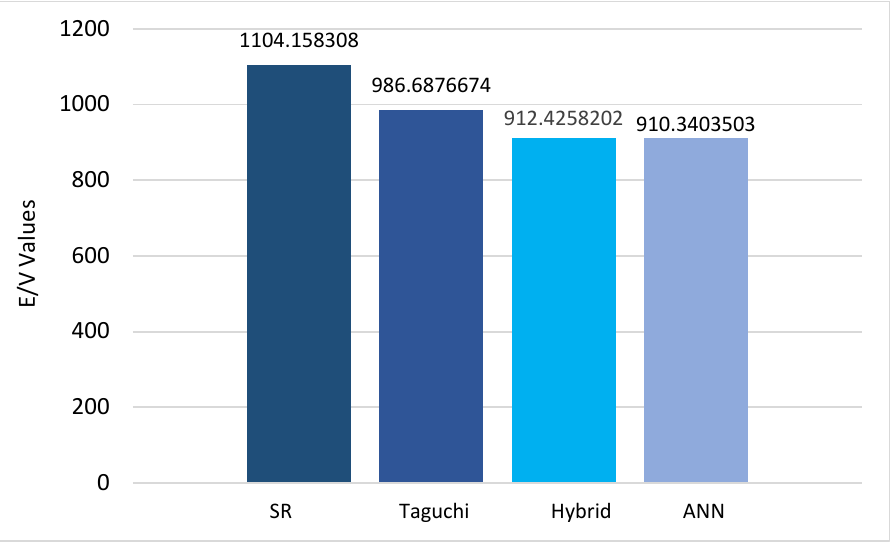
Figure 7. Average energy consumption for 28 testing variants (datasets) of Zamzam crude.